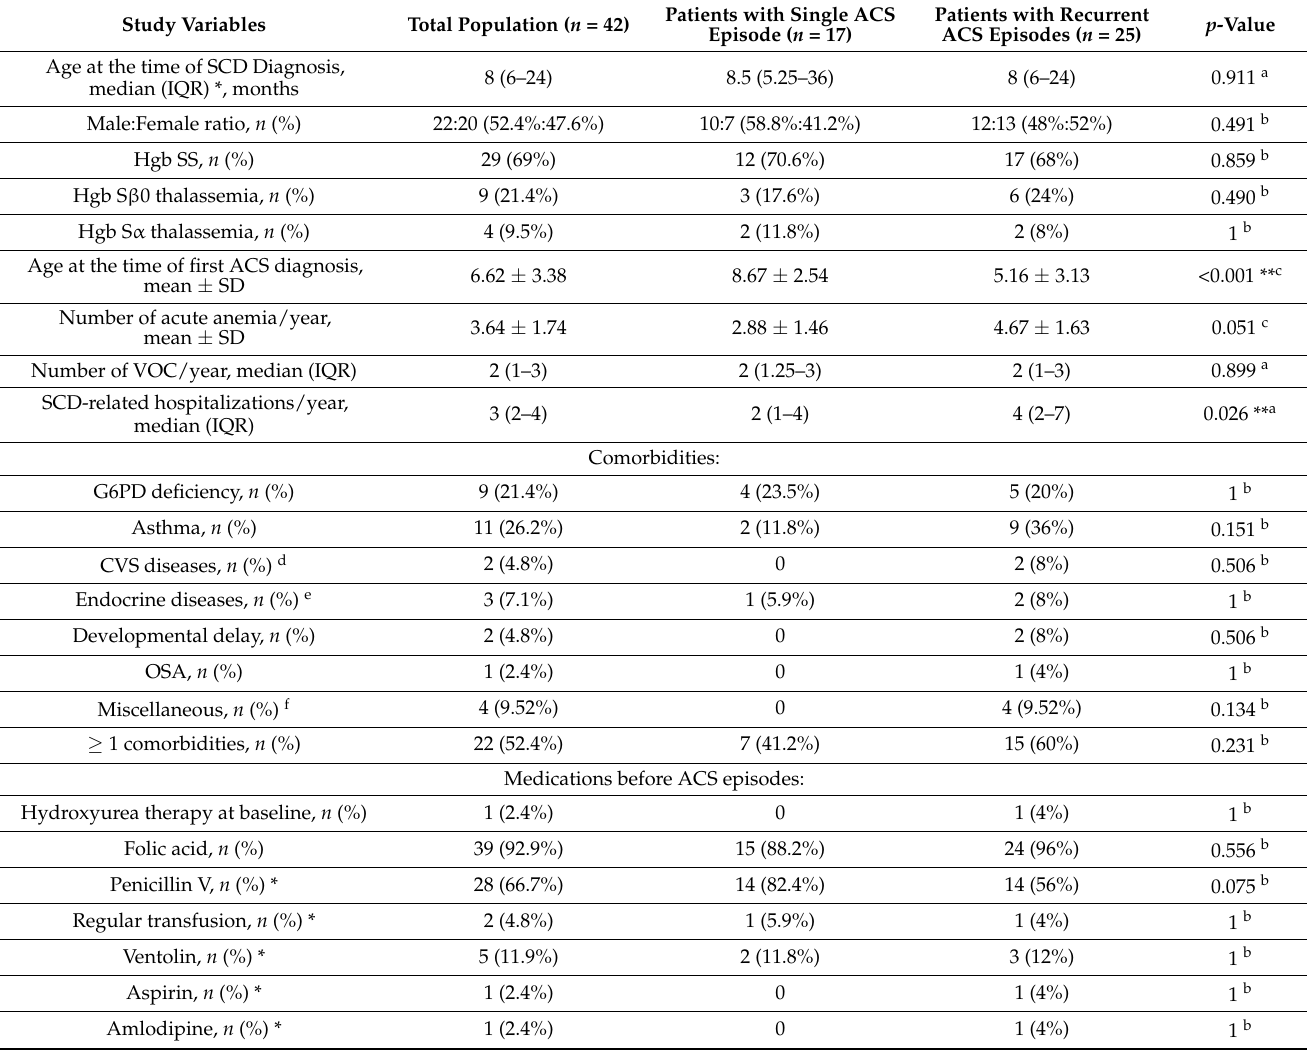
Table 1. Demographics and baseline characteristics of the included patients [ n =